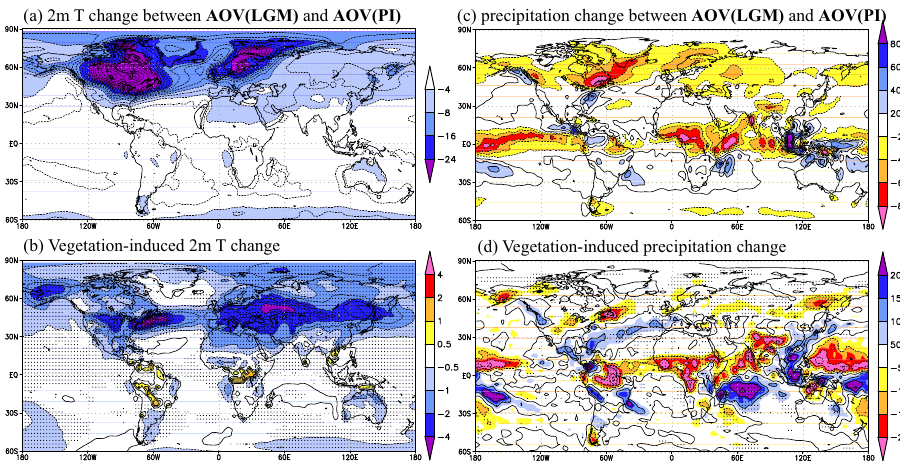
Fig. 4. Annual averaged 2m temperature change [K] (the contour interval is 2K) and precipitation change [mmyr − 1 ] (the contour interval is 100mmyr − 1 ) in the experiment AOV(LGM) from AOV(PI) are shown in panels (a) and (c) , respectively. Contribution of vegetation change in panels (b) (2m temperature, the contour interval is 1K) and (d) (precipitation, the contour interval is 100mmyr − 1 ) are calculated from (AOV(LGM) − AOV(PI))-(AO(LGM) − AO(PI)). Dotted areas show 95% significance by Student’s t-test.